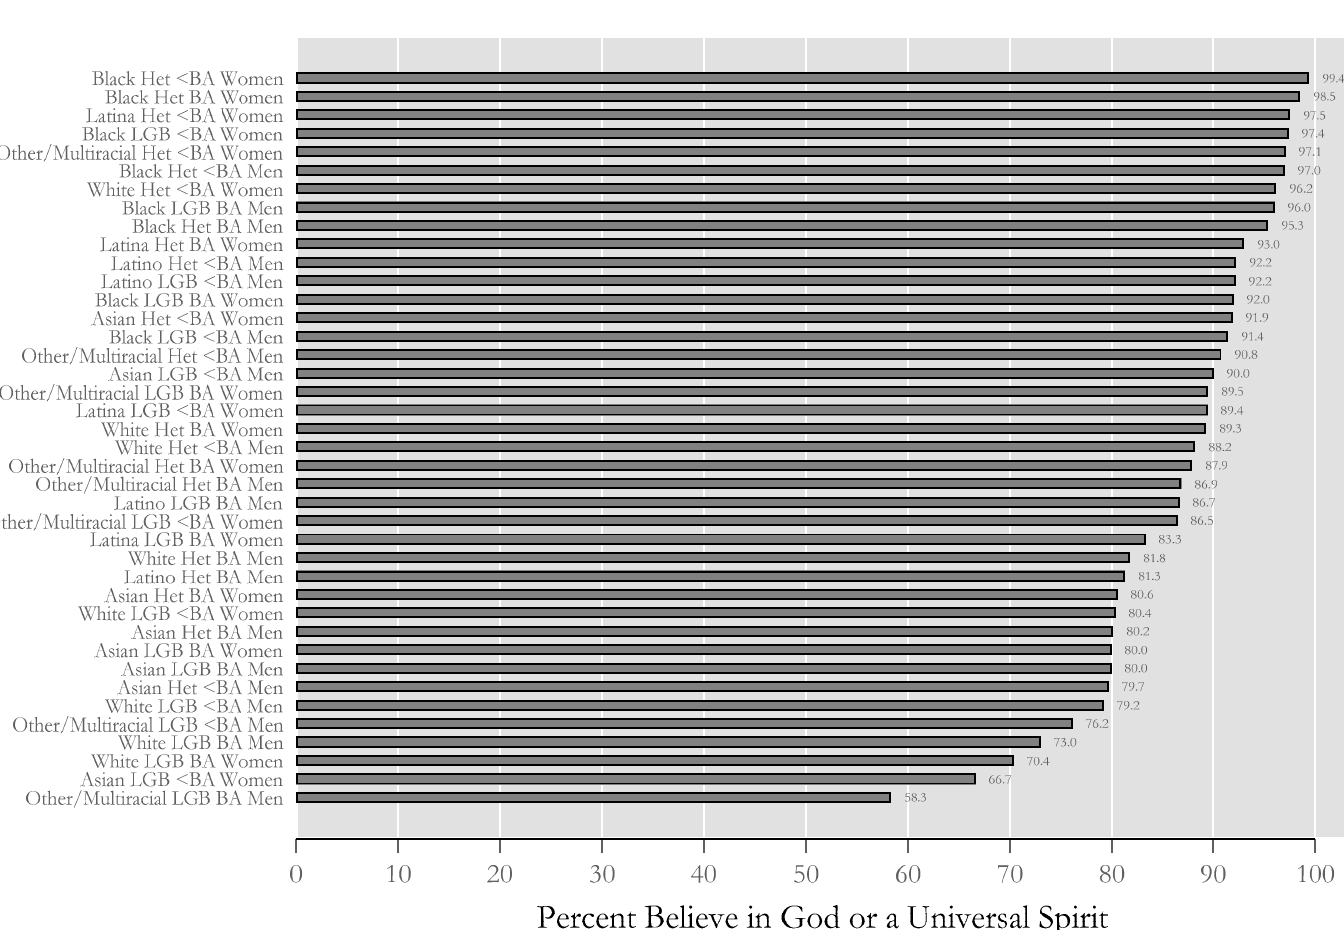
Figure 7. Belief in God or universal spirit across configurations of status characteristics, RLS (N = 32,681).